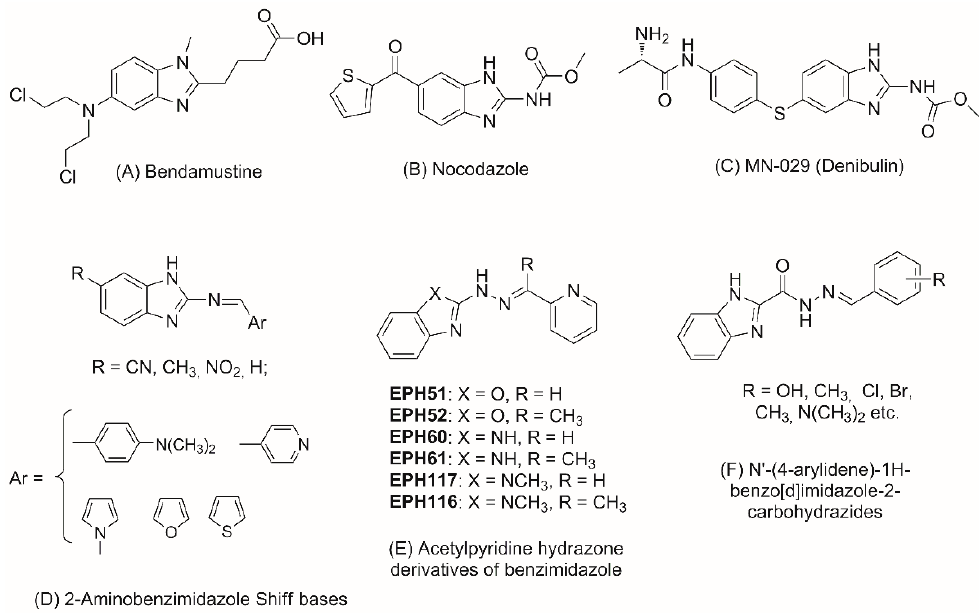
Figure 1. Benzimidazole derivatives with anticancer activity.